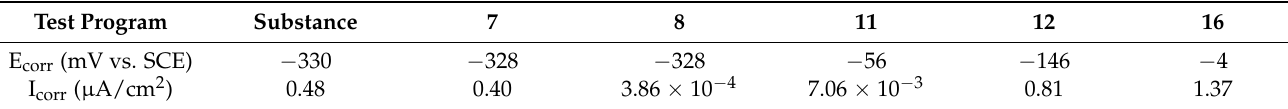
Figure 8. Polarization curves for selected items in the orthogonal experiment table. Table 2. Corrosion potentials and corrosion currents of substrates and experimental items.